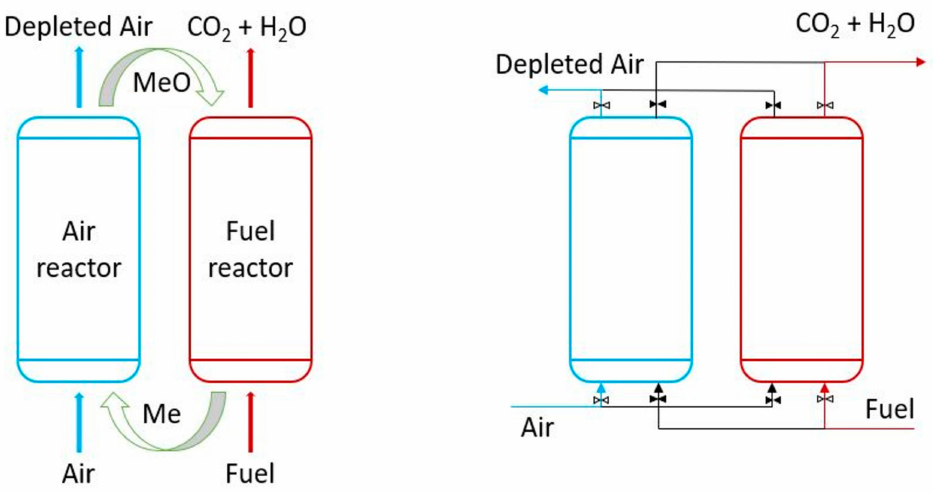
Figure 1. The chemical looping combustion process ( left ) and the gas switching combustion variant ( right ) that was investigated in this